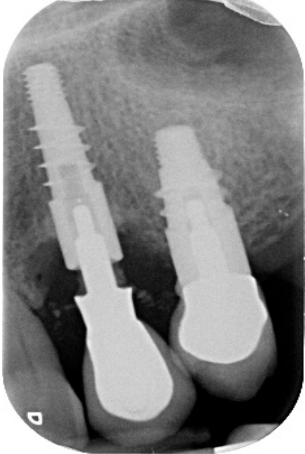
Figure 1. Pre-operative endoral X-ray.